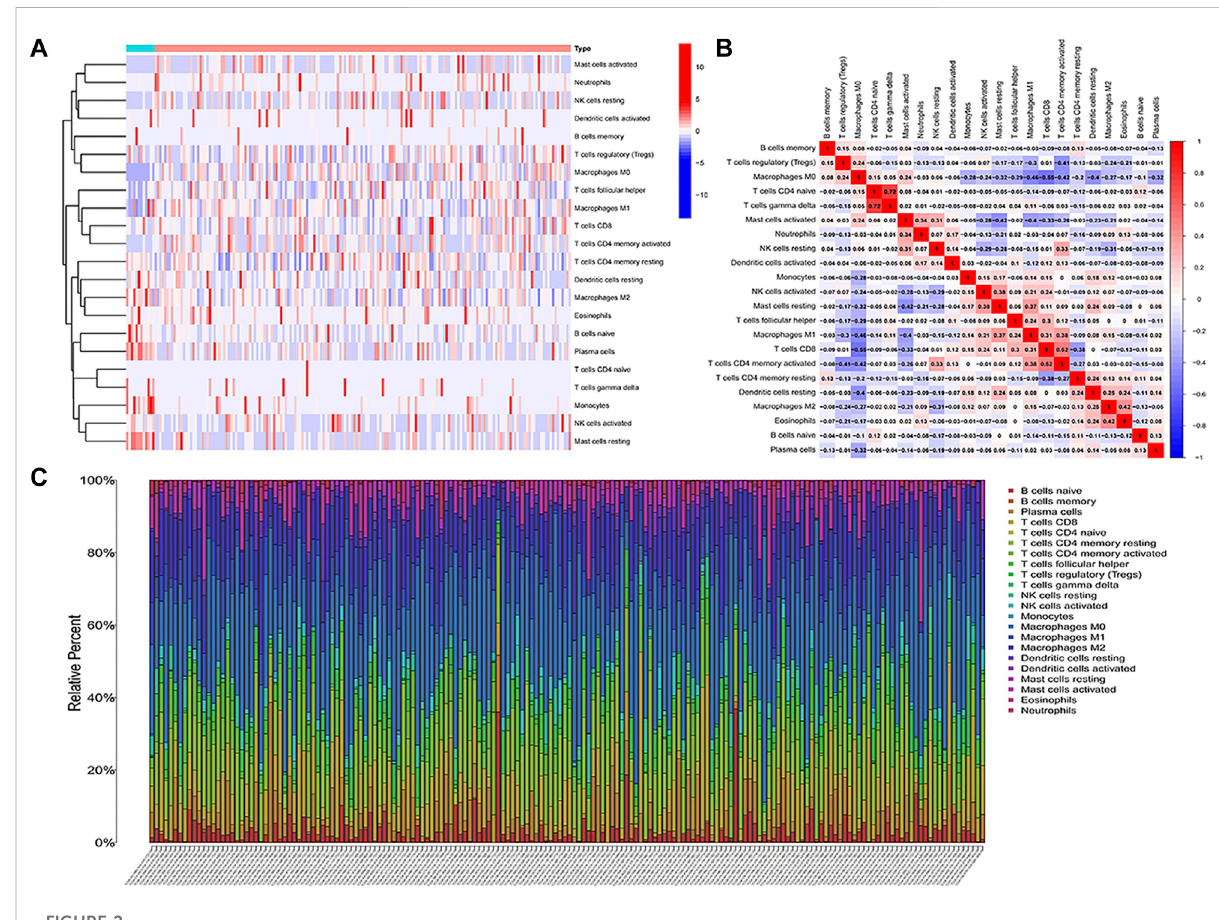
FIGURE 2 Analysis ofimmune cellin fi ltration. (A) Heatmapofthein fi ltration of22types ofimmunecellsinCOADandnormal samples. (B) Heatmapofthe mutual in fi ltration relationship between immune cells in COAD samples. (C) Histogram of the in fi ltration proportion of immune cells in each COAD